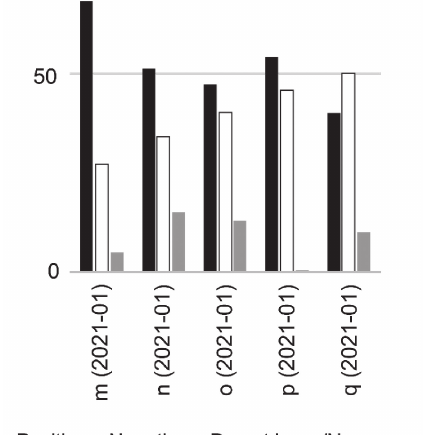
Figure 2. Responses to questions on introducing penalties for the non-compliant behaviors of infected persons Note: The values are in percentages (%). The abbreviations concerning the questions of the opinion polls and their timing of